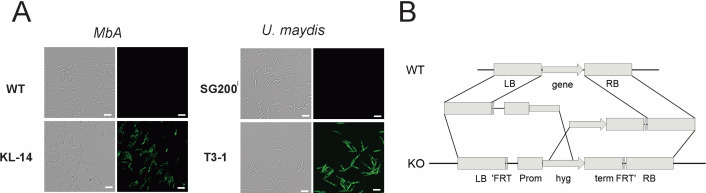
Genetic transformation of MbA.(A) Stable transformants that express cytosolic GFP could be obtained by generating protoplasts with Glucanex and ectopically integrating linear DNA fragments into the genome via polyethylene glycol (PEG)-mediated transformation. (B) Overview of the split-marker approach that was used to generate deletion mutants via homologous recombination.